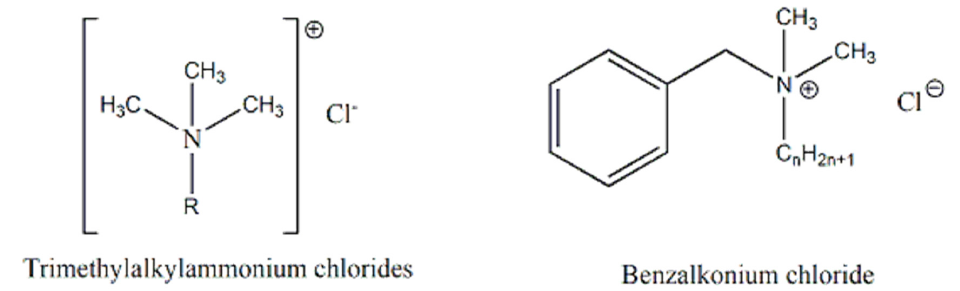
Figure 3. Chemical structure of some examples of cationic surfactants.